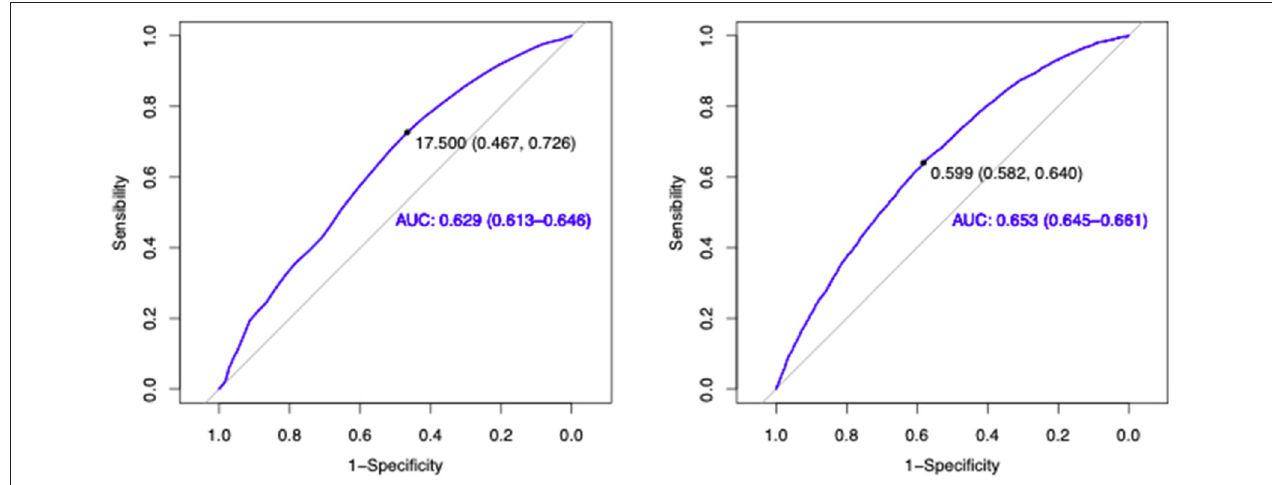
FIGURE 2 | ROC curves. Receiver operating characteristic (ROC) curves defining cutoff points for HS (A) and GS (B) as markers for cognitive impairment. The dot represents the point with the largest AUC. Area under the curve: (A) 0.629 (CI 95%: 0.613–0.646), (B) 0.653 (CI 95%: 0.645–0.661). AUC, area under the curve; HS, handgrip strength; GS, gait